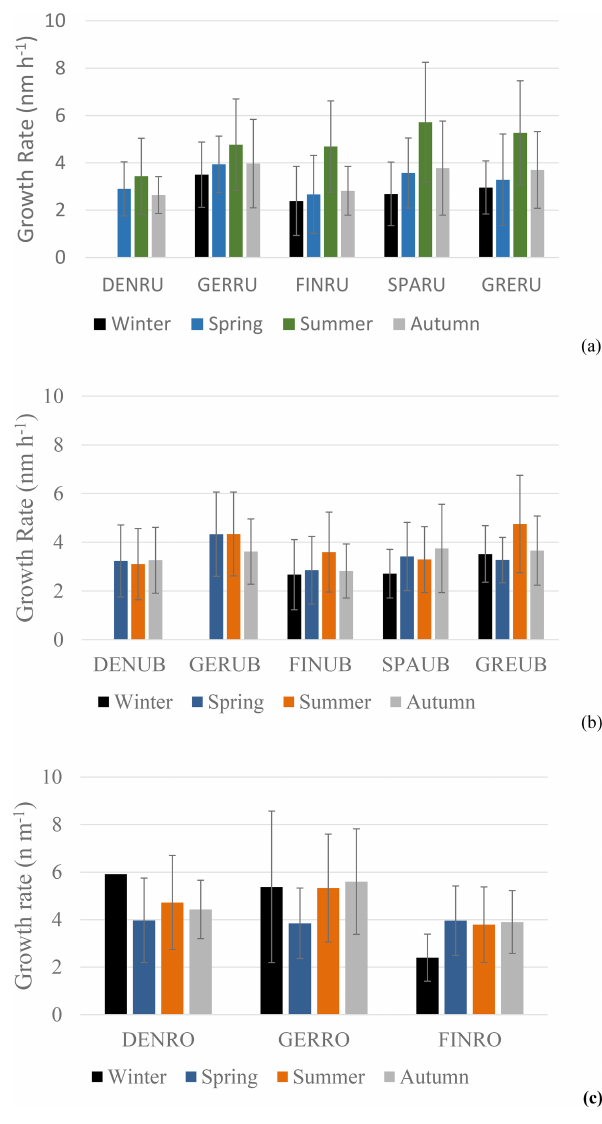
Figure 5. Seasonal variation of growth rate of particles up to 30nm on new particle formation at (a) the rural background, (b) urban background, and (c) roadside